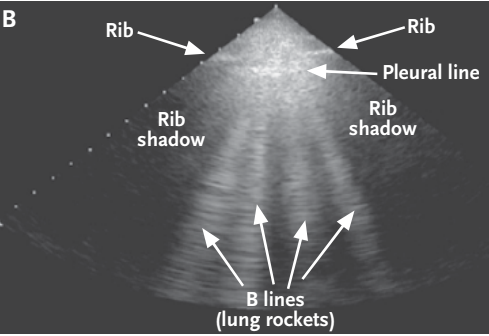
Figure 2. Ultrasound image created by a sector converter with B-lines